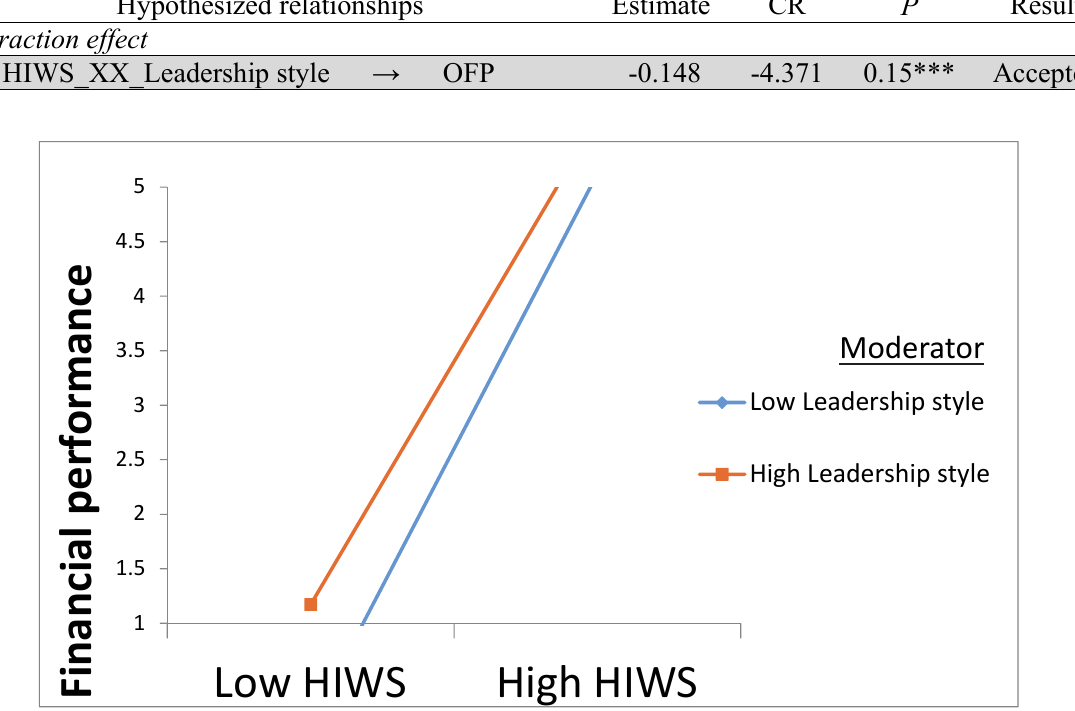
Fig. 8. Leadership style interaction